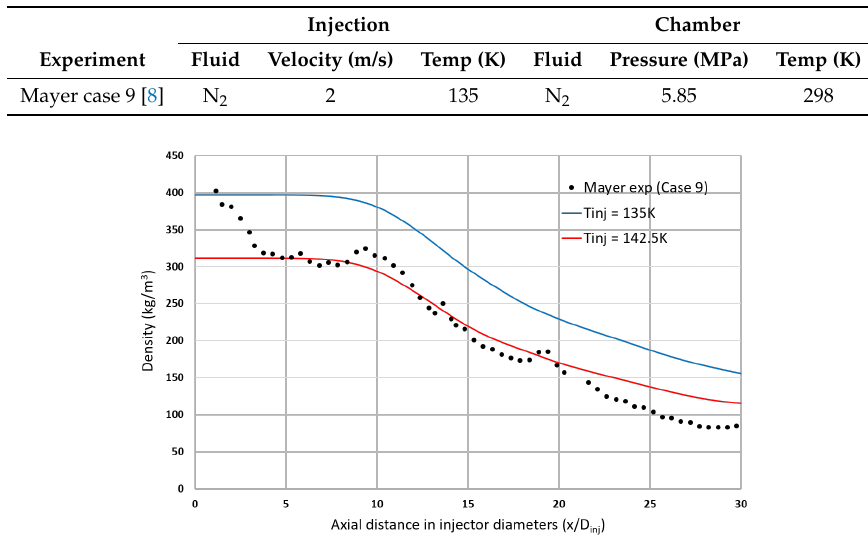
Table 5. Table of injection and chamber conditions associated with Mayer’s case 9 [8].